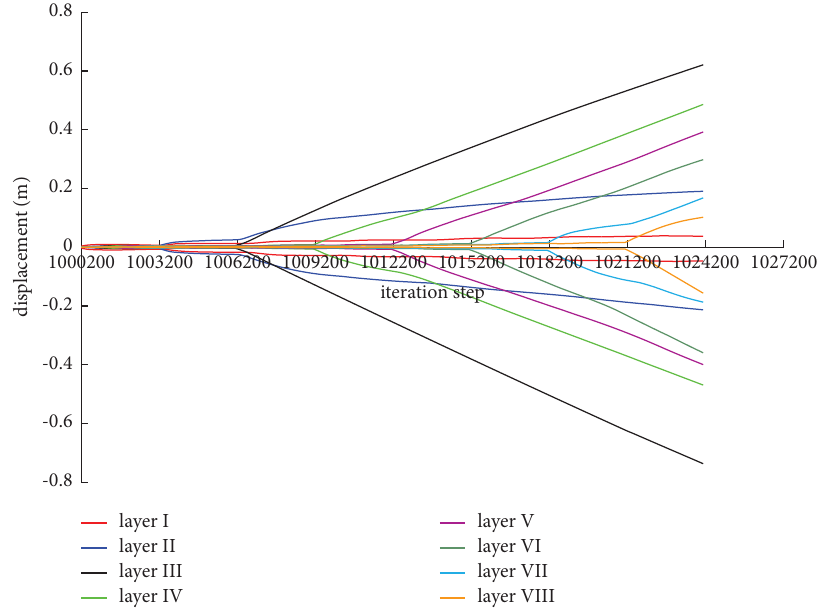
Figure 9: Te displacement curve of characteristic points at left and right side walls. Table 6: Grids characteristics under diferent simulation scales.